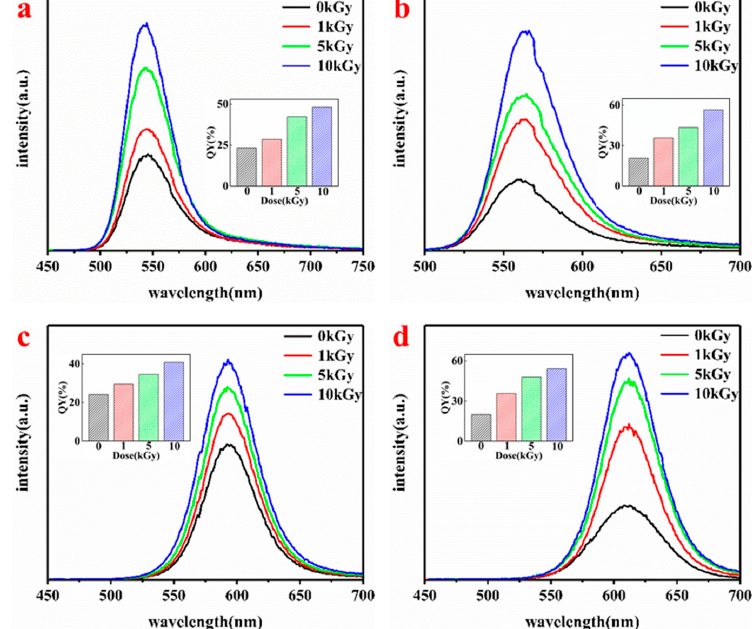
Figure 3. PL spectra and quantum yield of MPA-CdTe QDs with different particle sizes (QDs-545 ( a ), QDs-567 ( b ), QDs-592 ( c ) and QDs-608 ( d )) after γ -irradiation. QDs-567 ( b ), QDs-592 ( c ) and QDs-608 ( d )) after γ